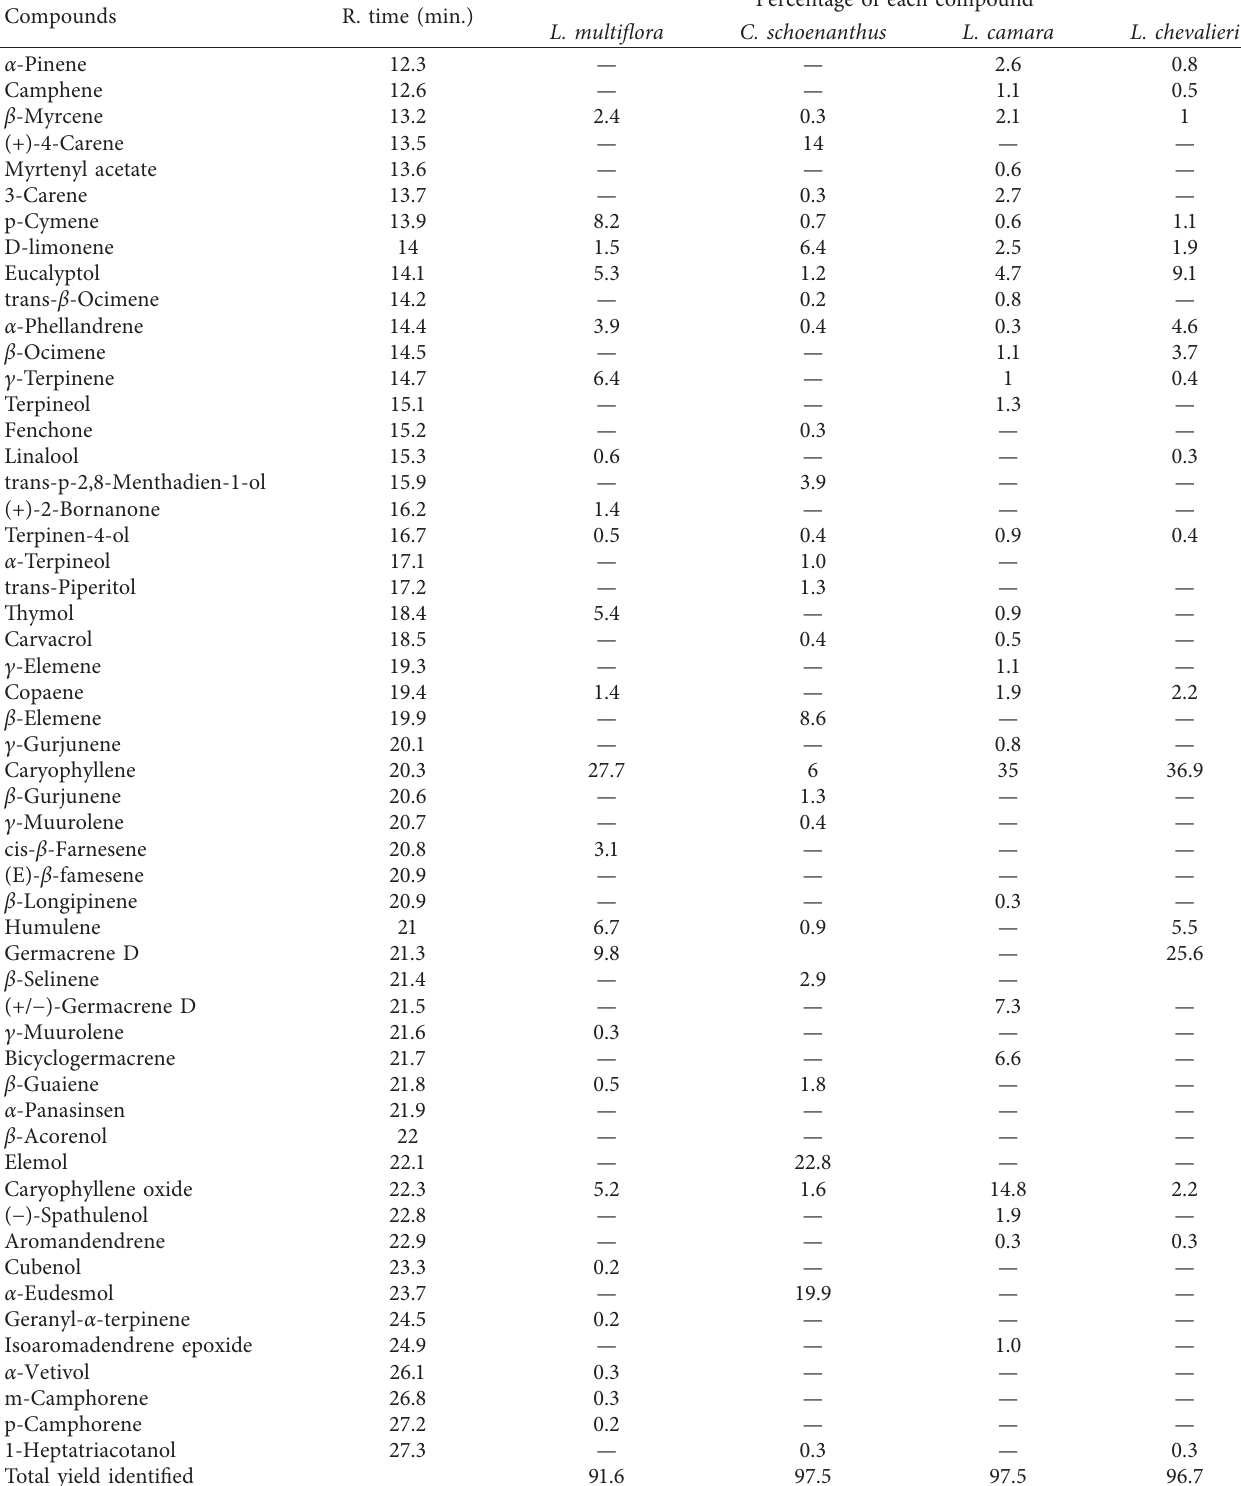
Table 2: Chemical composition and essential oil yields of